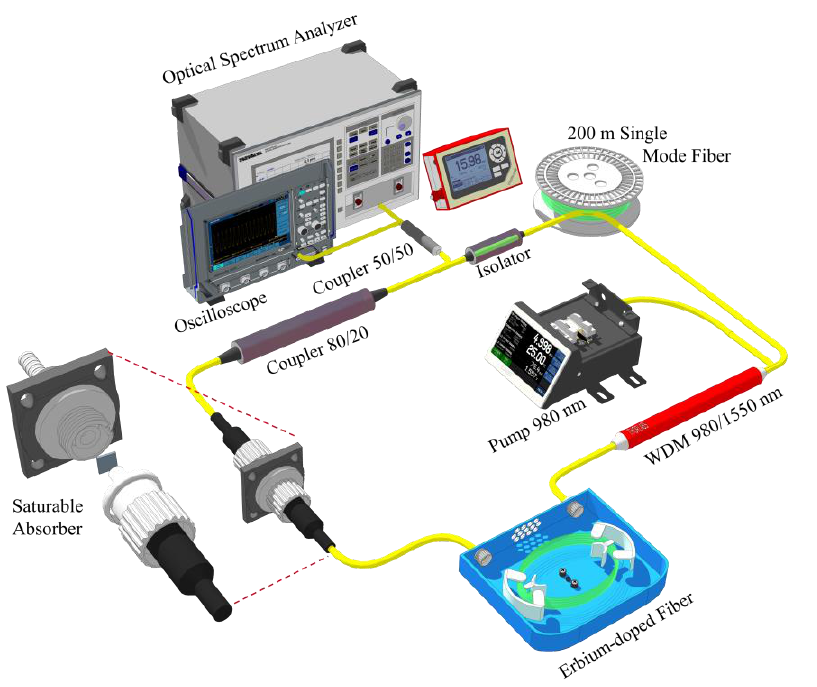
Figure 5. Schematic of the mode-locked fiber laser utilizing Nb 2 AlC-PVA SA with the addition of 200 m long SMF.